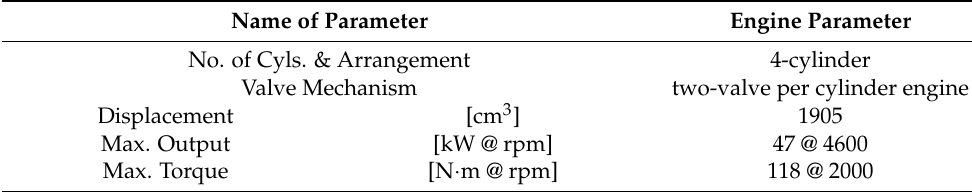
Table 1. Basic engine parameters. Name of Parameter Engine